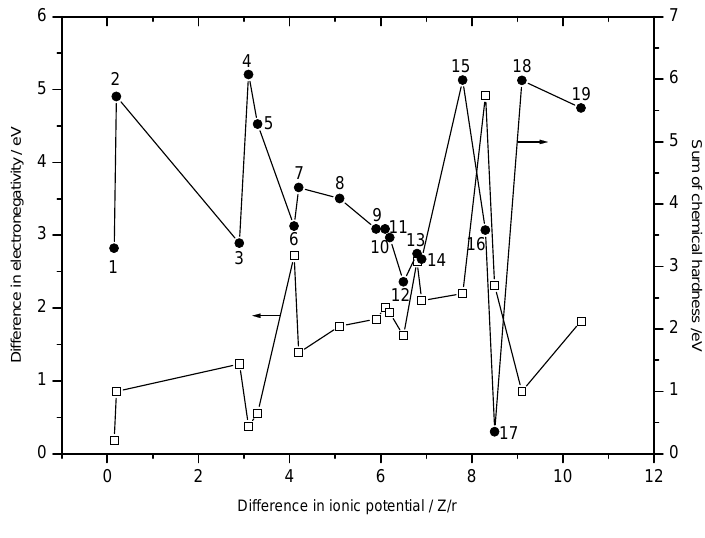
Figure 8. Relationship among the difference in electronegativity, sum of chemical hardness, and dif- ference in ionic potential of certain solid oxides with coordination number of 6. (Open squares denote difference in electronegativity; numbers next to data points correspond to the numbers used in Table 3 for each oxide pair).